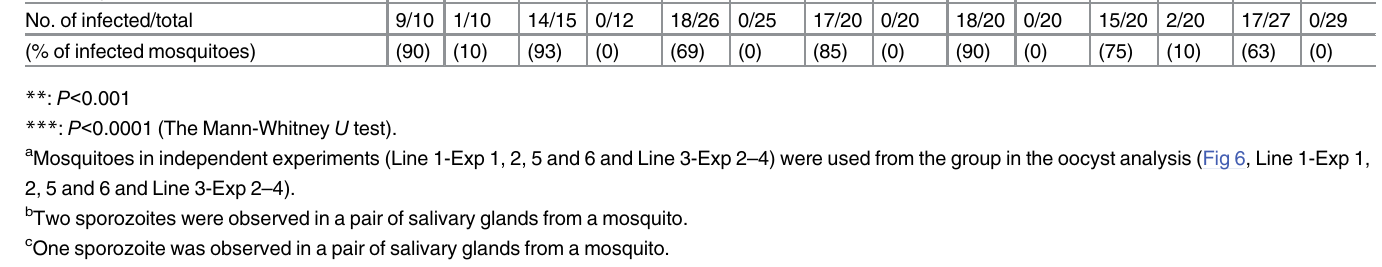
*** : P < 0.0001 (The Mann-Whitney U test). a Mosquitoes in independent experiments (Line 1-Exp 1, 2, 5 and 6 and Line 3-Exp 2 – 4) were used from the group in the oocyst analysis (Fig 6, Line 1-Exp 1, 2, 5 and 6 and Line 3-Exp 2 – 4). b Two sporozoites were observed in a pair of salivary glands from a mosquito. c One sporozoite was observed in a pair of salivary glands from a mosquito.